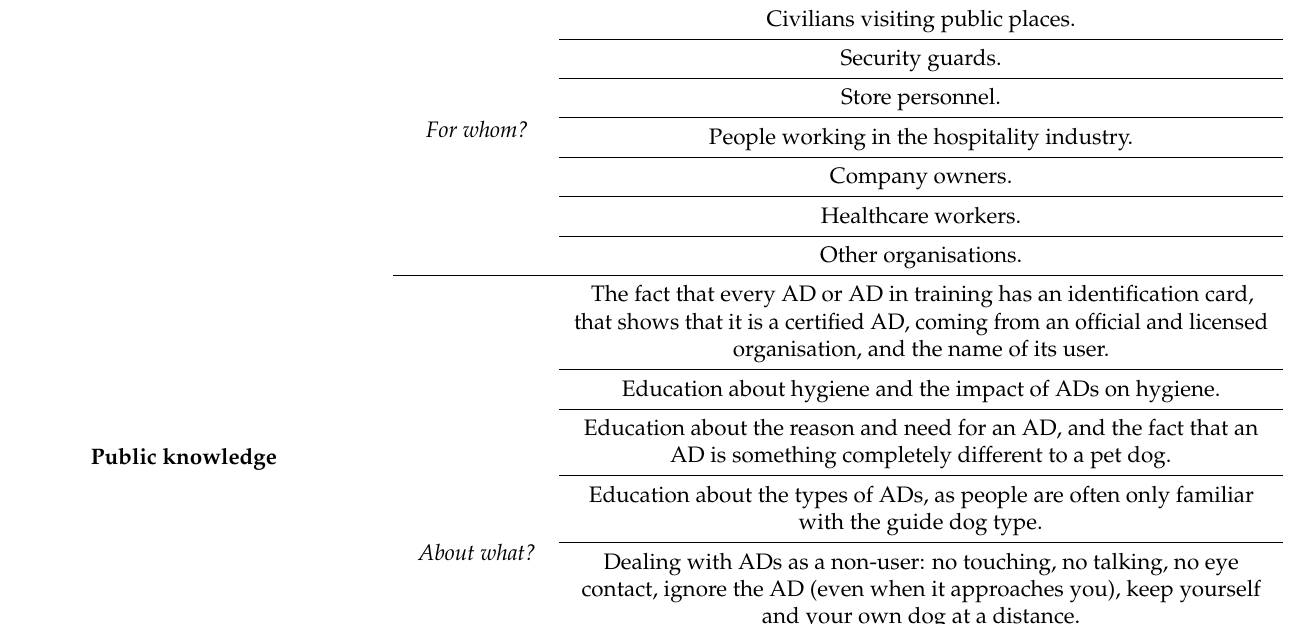
Table 6. Possible improvements in the infrastructure of public space, public knowledge, and other topics regarding assistance dogs (ADs), as mentioned by AD